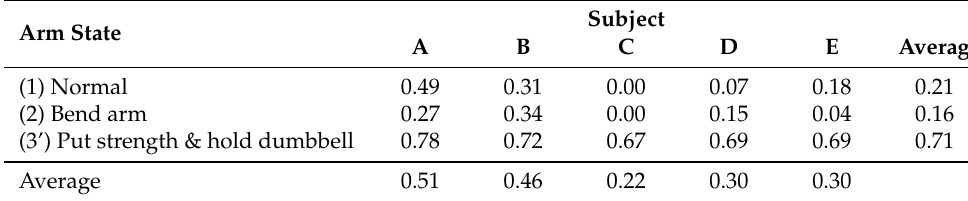
Table 2. Results of muscle activity recognition